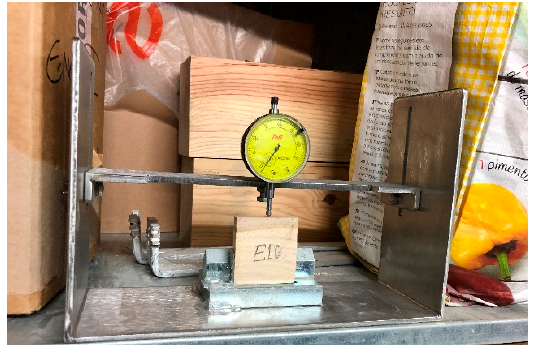
Figure 2. Test setup used to measure the specimens. Table 1. Radial ( ε R ) and tangential ( ε T ) linear shrinkage measured on the eucalyptus wood specimens according to ISO 13061-1